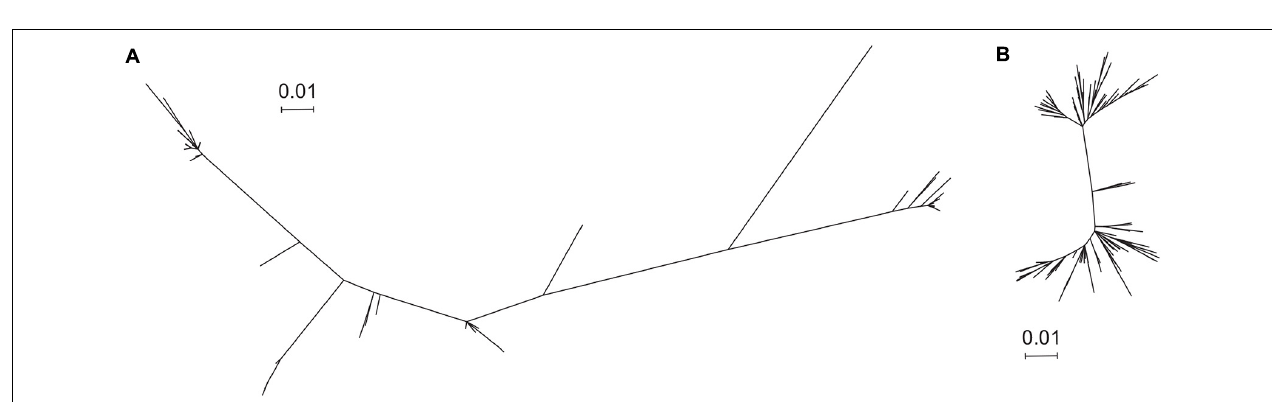
FIGURE 1 | Conservation matrices of HCMV proteins integral to the virion envelope. Percentage of amino acids identity is represented as matrices using hierarchical clusters from the “ComplexHeatmap” R package. The following proteins are represented: (A) Four viral G protein-coupled receptors (UL33, UL78, US27, and US28) and two glycoproteins (gN and gM); (B) Glycoproteins with unknown function gp1, gp42, gp48, and gpTRL10; (C) Protein UL116, proteins composing the pentamer (gH, gL, pUL128, pUL130, and pUL131A) and the trimer (gH, gL, and gO) complexes; (D) gB.